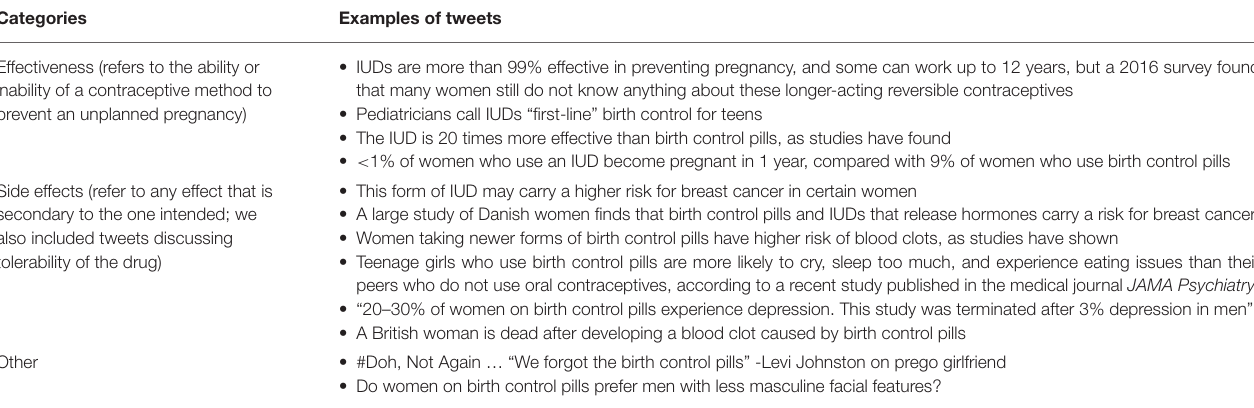
TABLE 1 | Definitions of the medical categories and examples. Categories